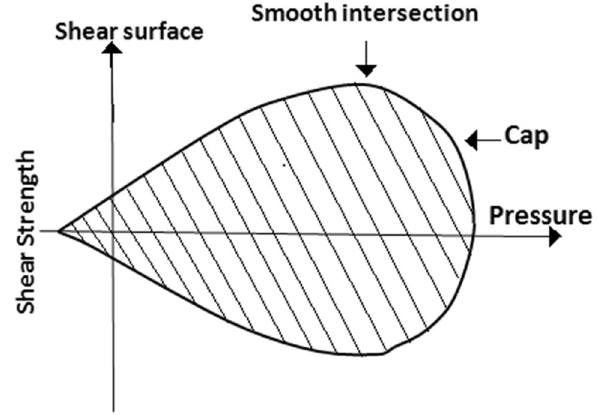
Fig. 1 Failure surface of the CSCM material model.